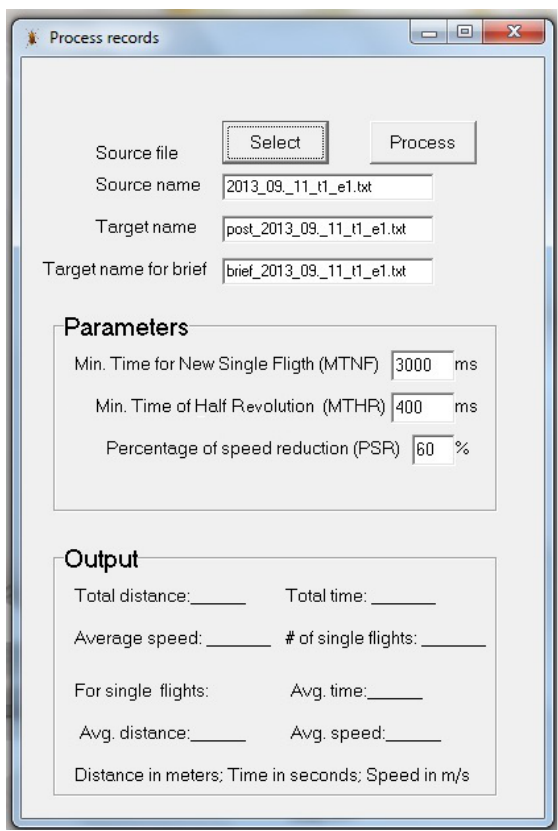
Figure 14. Interface of the application for processing